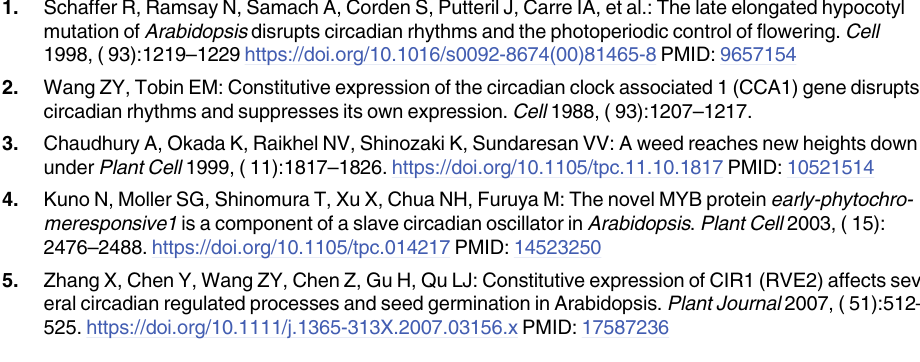
S2 Table. Comparison of seed size of T2 transgenic progeny plants harboring gene constructs A , B and C and that of wild type (WT). S3 Table. Comparison of average chlorophyll content (mgg-1) in T1 transgenic progeny plants at different time points; 6:00AM, 12:00 Noon, 6:00 PM and 9:00 AM the following